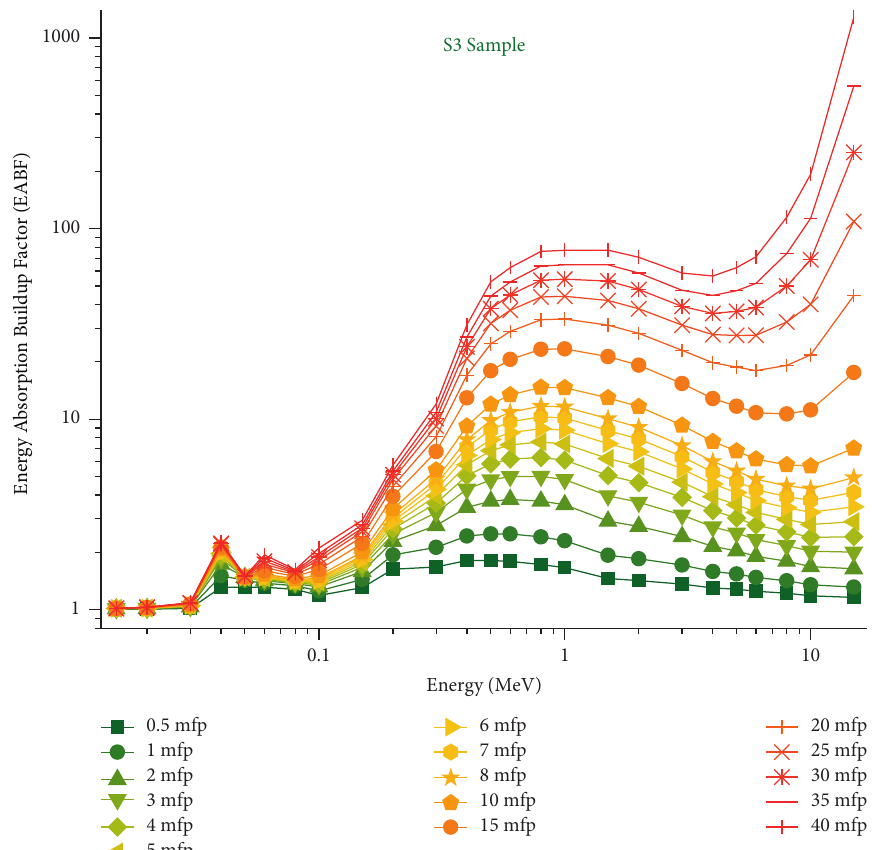
Figure 15: Demonstrates the relationship between the energy and EABF of the S3 sample. Table 3: (EBF and EABF) G–P fitting coefficients ( b , c , a , X